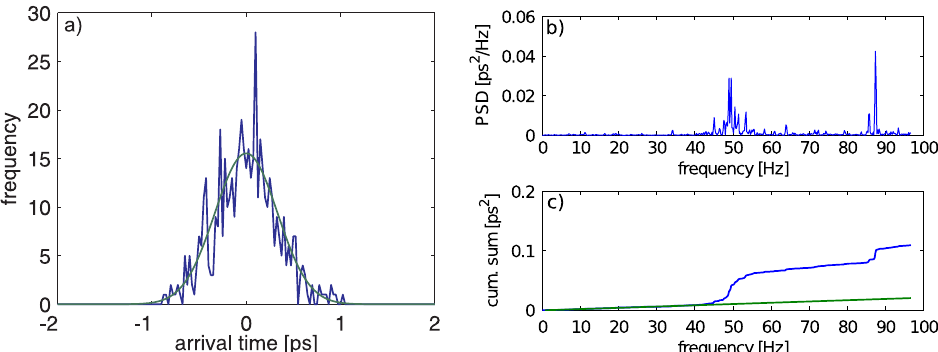
FIG. 11. (a) Histogram of the arrival time jitter (blue line) and a fitted Gaussian distribution with a rms width of 330 fs (green curve). (b) Power spectral density of the arrival time jitter. (c) The cumulative sum (blue curve) indicates the jitter contribution at different frequencies and the uncorrelated jitter of 145 fs (green curve) is the minimal resolution of the